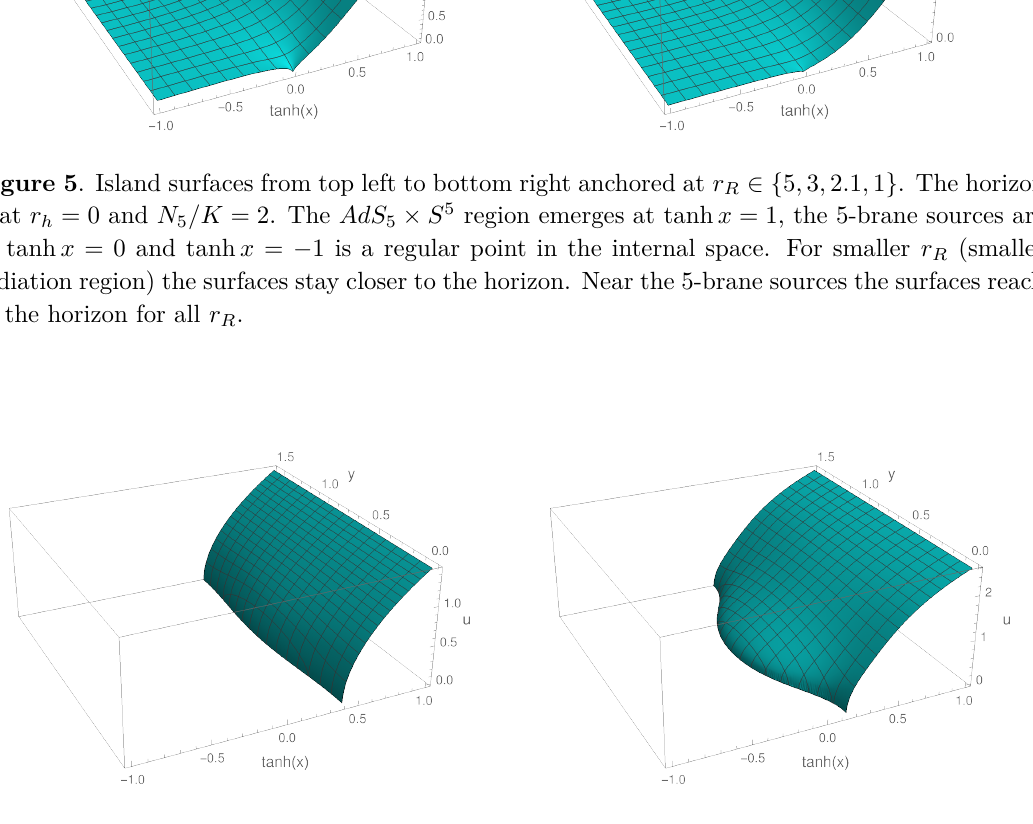
Figure 6 . HM surfaces at t = 0 for r R = 1 (left) and r R = 2 . 1 (right), with r h = 0 and N 5 /K = 2 . The plots show the tortoise radial coordinate u , in which the horizon is intersected orthogonally. The further the HM surfaces are anchored from the horizon at r h = 0 , the further they reach towards negative x